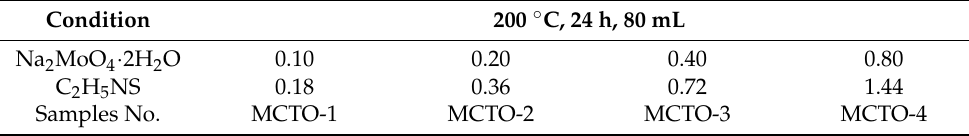
Scheme 1. Schematic diagram of the preparation process of the samples. Table 1. Preparation conditions for the MCTO composites.